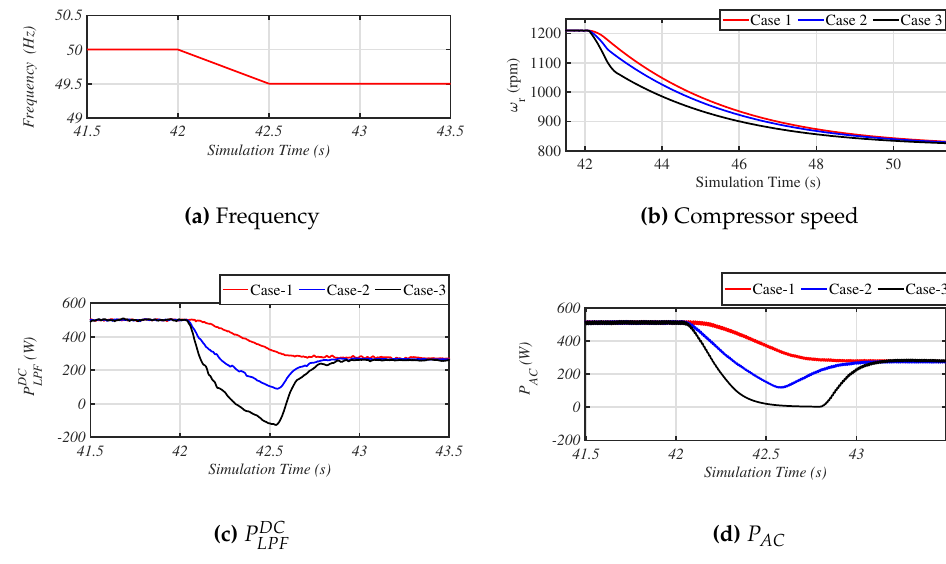
Figure 8. VSHP measured test